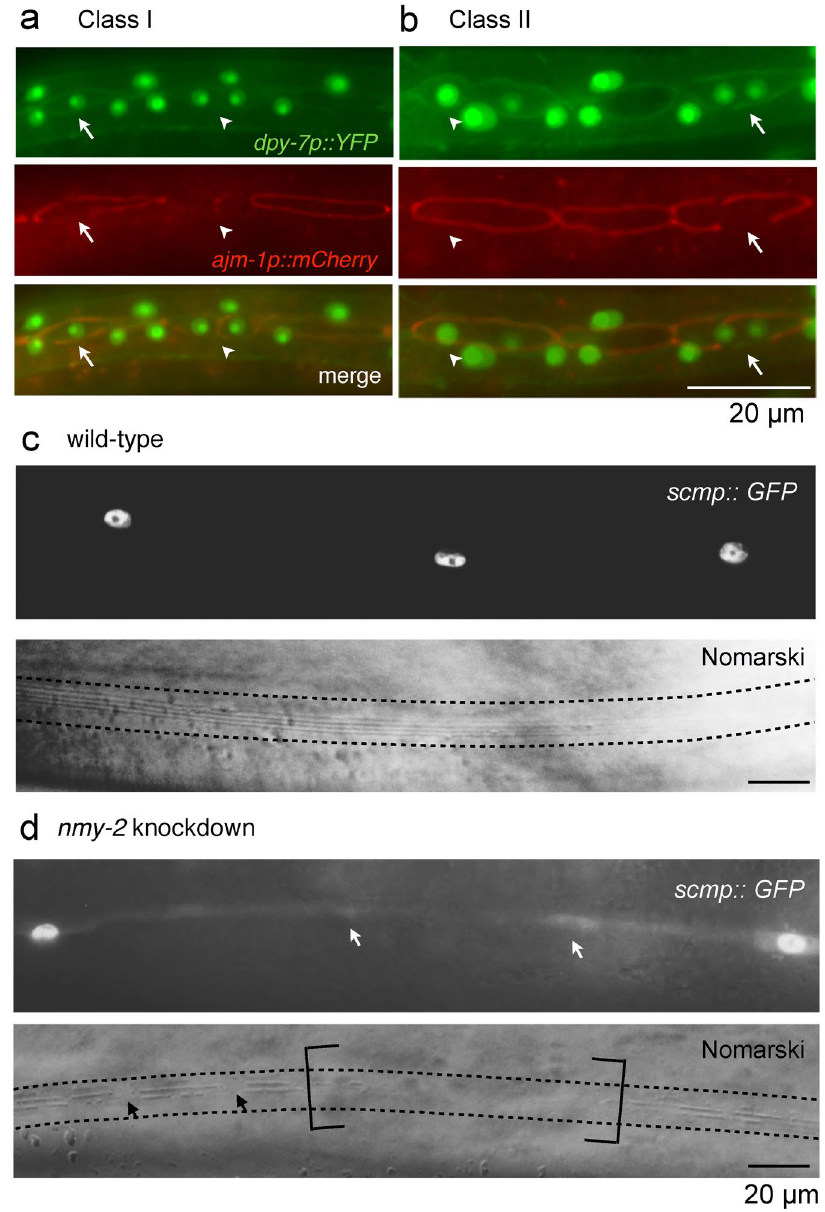
Figure 4. Class I and II fate transformations resemble normal hypodermal differentiation. ( a , b ) Worms with the dual-colour fate reporter ouIs10 and the integrated apical junction marker ouIs21 (strain AW1106) were subjected to nmy-2 knockdown and representative snapshots were taken after the L3 division. ( a ) Class I phenotype. Arrow points to the broken apical junction in a seam daughter that should normally be protected from receiving differentiation signals. Arrowhead points to a Class II event next to a Class I event in the same worm. ( b ) Class II phenotype. Arrow points to the broken apical junction in a seam daughter that should normally be protected from receiving differentiation signals. Arrowhead points to a cell at the transitional stage where the hypodermal marker is expressed more strongly in the anterior nucleus than the posterior one. ( c ) Wild-type seam syncytium produced smooth, continuous alae (between dotted lines) (strain AW335). ( d ) The nmy-2 knockdown animal had missing seam nuclei (white arrows) that correlated with absent (brackets) or broken (black arrows) alae ridges (strain AW785). Young adults were imaged in ( c ) and ( d